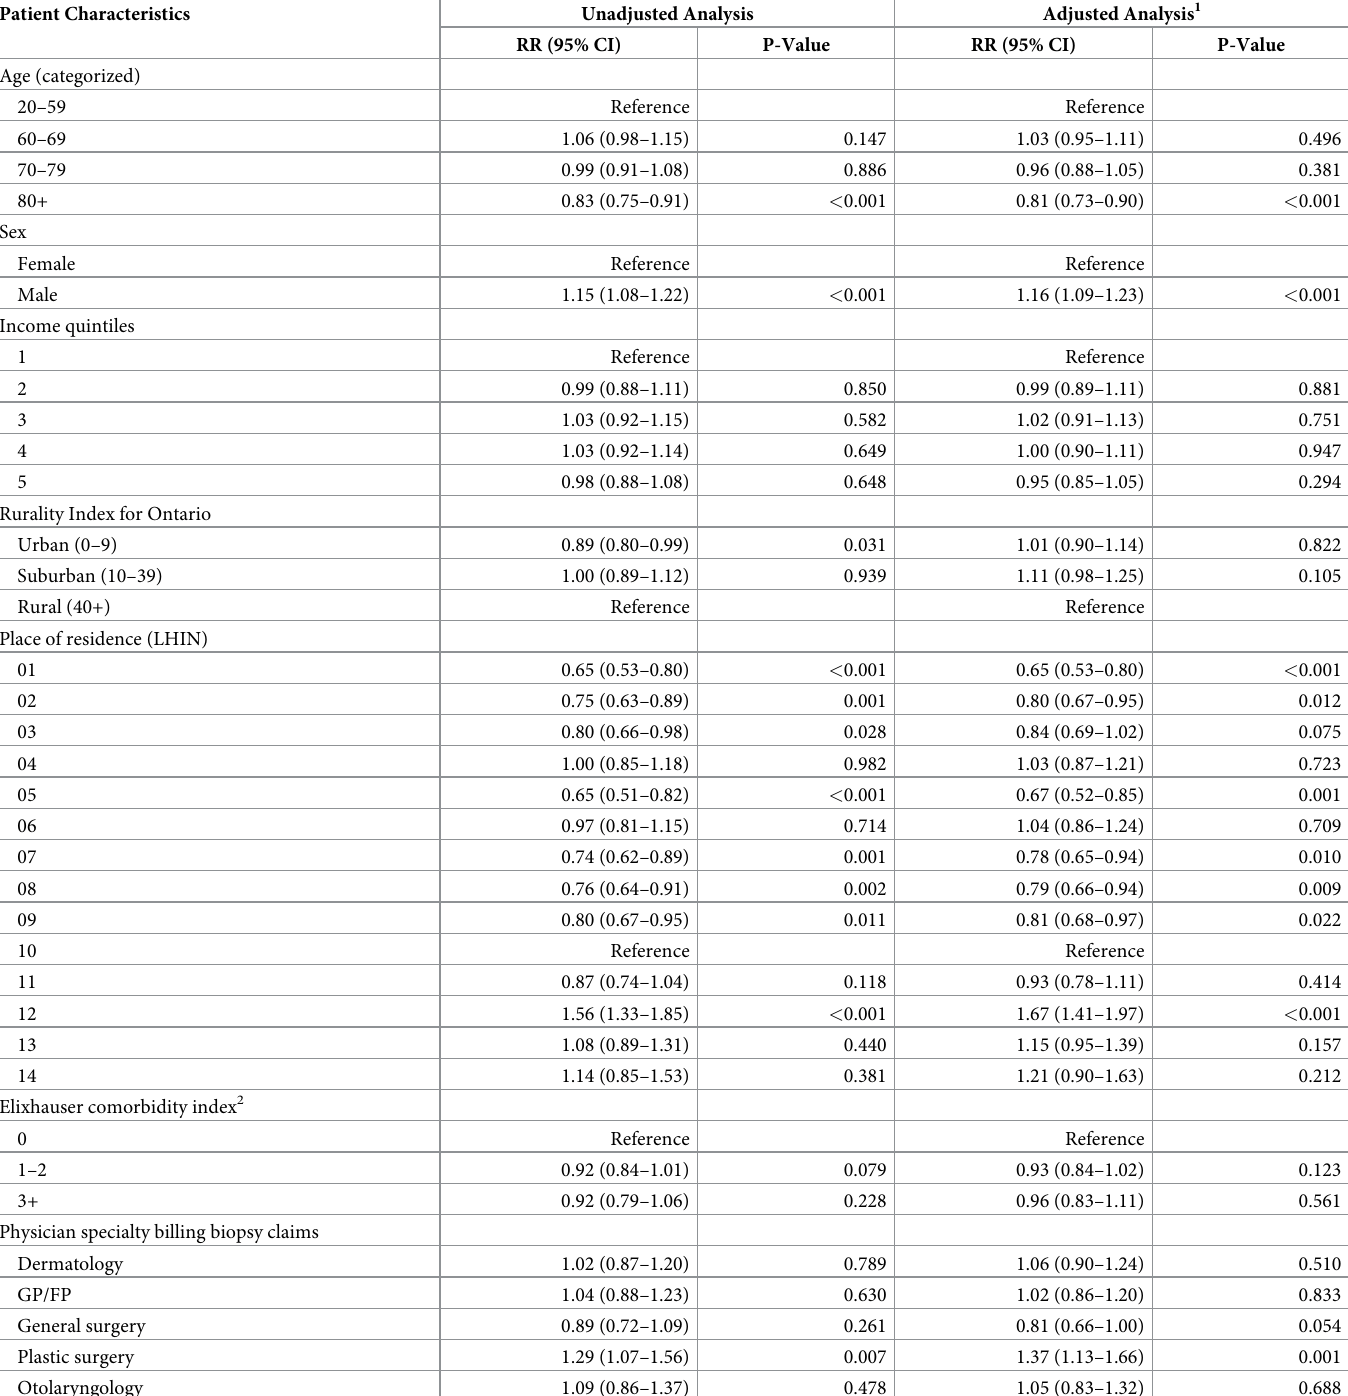
Table 2. Relative risks for comparing all skin biopsy claims between COVID-19 (Weeks 11–15) and pre-COVID-19 (Weeks 1–10) periods for the first 15 weeks (starting on Monday) of